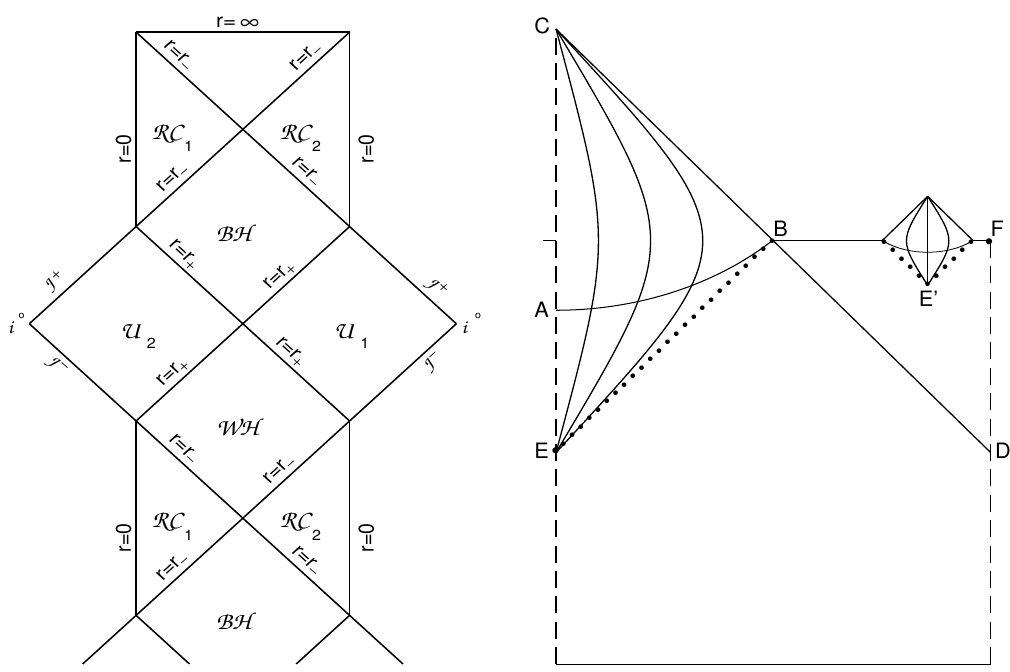
Figure 3. Left : Quantum birth of a closed universe inside a Λ BH; Right : Penrose–Carter diagram [40] for the case of quantum birth of an open or flat